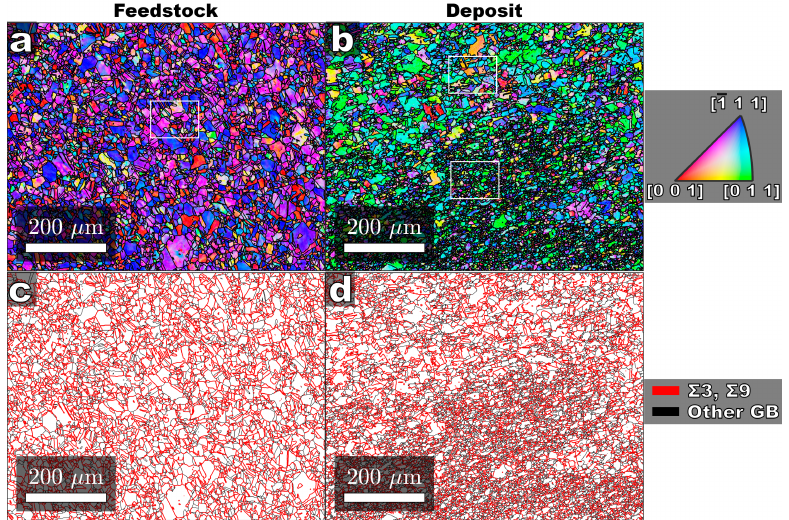
Figure A2. Full set of microstructural maps resultant from EBSD survey scans of feedstock and deposit center. We duplicate ( a , b ) from Figure 4a,b for completeness of the figure and to facilitate comparison. The rows correspond to inverse pole figure maps ( a , b ) and twin/non-twin grain boundary maps ( c , d ). The color schemes are depicted to the right of each